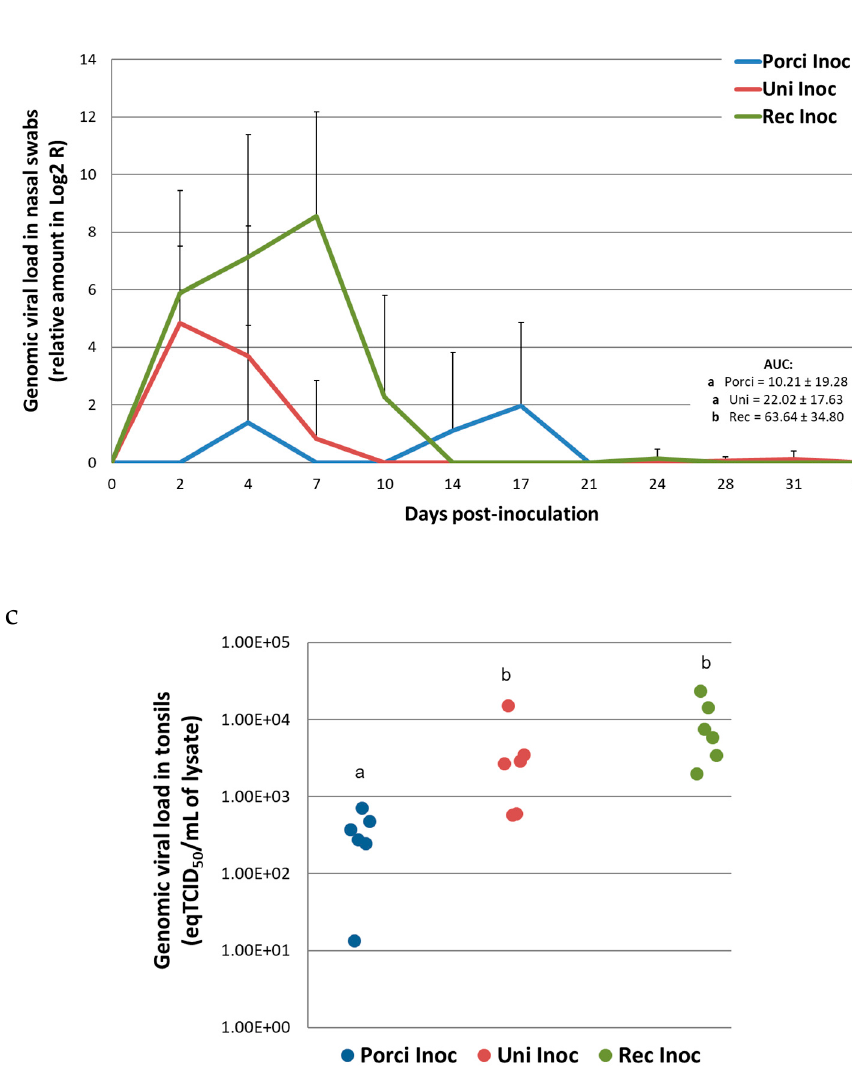
Figure 2. Genomic viral loads in serum, nasal swabs, and tonsils from inoculated pigs. ( a ) Evolution of the mean genomic viral loads in inoculated pigs from the Porci, Uni, and Rec groups in serum (equivalent TCID 50 /mL of serum) after inoculation (day 0). AUC: Area Under the Curve. Different letters (a, b, c) indicate that the groups are significantly different from each other with p ≤ 0.05. ( b ) Evolution of the mean genomic viral loads in inoculated pigs from Porci, Uni, and Rec groups in nasal swab supernatants (relative amount expressed in log2 R) after inoculation (day 0). AUC: Area Under the Curve. Different letters (a, b) indicate that the groups are significantly different from each other with p ≤ 0.05. ( c ) Post-mortem analysis of individual genomic viral loads in tonsils (equivalent TCID 50 /mL of tissue lysate) at 36–39 dpi in inoculated pigs from Porci, Uni, and Rec groups. Different letters (a, b) indicate that the groups are significantly different from each other with p ≤ 0.05.